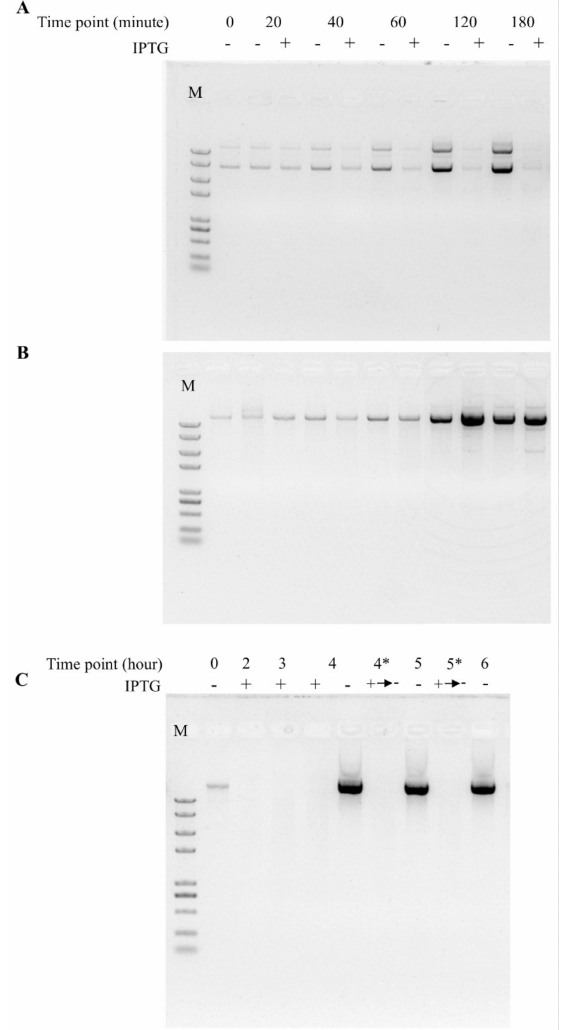
Figure 3. TtAgo induction reduces recovery of the expression vector. pET28a-TtAgo and pET28a plasmids were extracted from 1 mL of cell culture under inducing or non-inducing conditions and analyzed by agarose gel electrophoresis. ( A ) Equal volume of extracted pET28a-TtAgo plasmid was loaded. “Time point” represents the bacterial growth time after OD 600 reaches 0.5, and IPTG induction and no induction treatments were indicated as “+” and “ − ”. M, 2K Plus II marker (TransGen), suitable for all three figures. ( B ) Equal volume of extracted pET28a plasmid was loaded. “Time point” represents the bacterial growth time after OD 600 reaches 0.5, and IPTG induction and no induction treatments were indicated as “+” and “ − ”. ( C ) Equal volume of extracted pET28a-TtAgo plasmid was loaded. “Time point” represents the bacterial growth time after OD 600 reaches 0.5, and IPTG induction and no induction treatments were indicated as “+” and “ − ”. “4*” represents 4-h IPTG induction growth plus another 1-h no induction growth, consistent with the “+ →− ” label on IPTG induction treatment; “5*” represents 4-h IPTG induction growth plus another 2 h no induction growth, consistent with the “+ →− ” label on IPTG induction